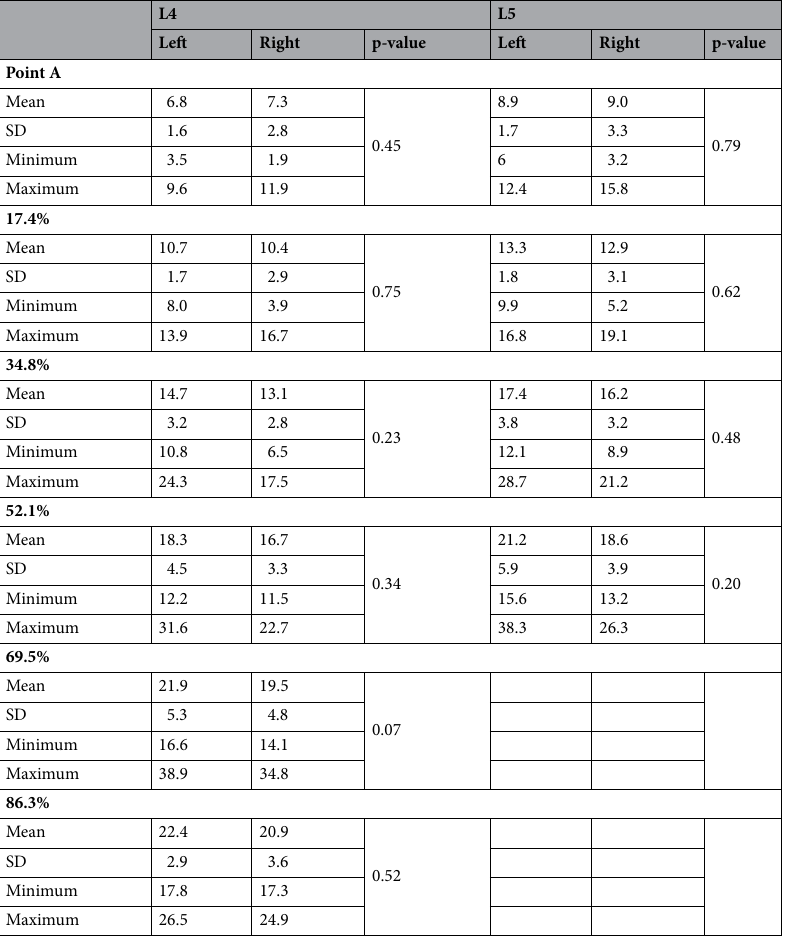
Table 3. Side differences of intervals between the ventral branches of L4/L5 and respective measurements points (Point A on the linea terminalis and 17.4%/34.8%/52.1%/69.5%/86.3% of the total length of the sacro- iliac joint). Data are presented in